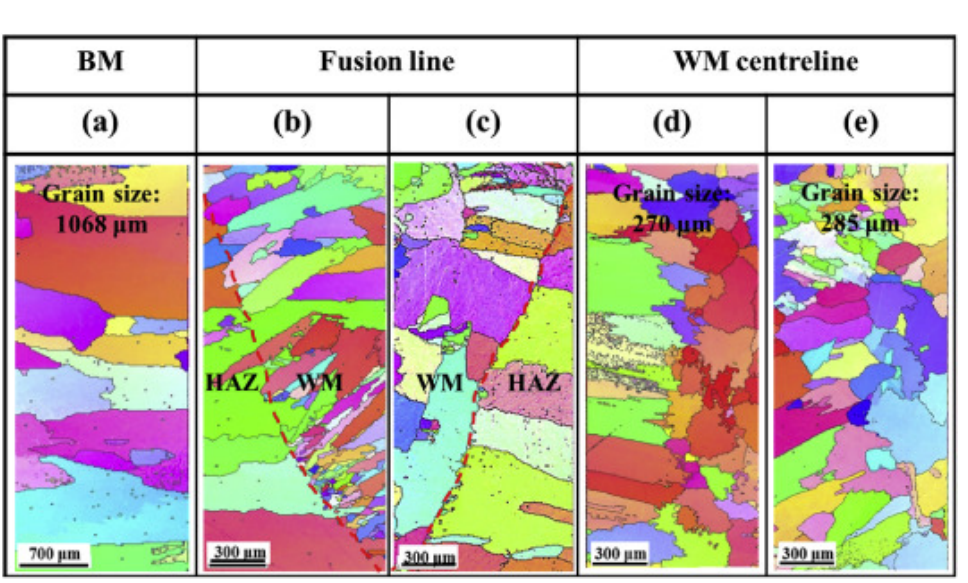
Figure 4. EBSD of ( a ) BM, ( b ) HAZ and WM of HEA fillers, ( c ) HAZ and WM of STS 308 L, ( d ) center of WM of HEA fillers, ( e ) center of WM of STS 308 L. Reproduced with permission from [80]. Copyright Elsevier, 2020.